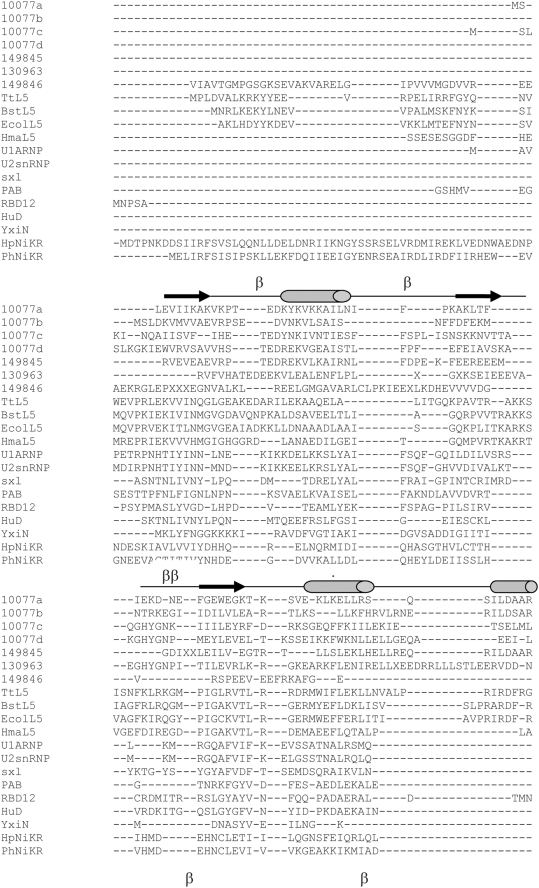
Sequence alignment of UPF0201 proteins (that include known structures and consensus sequences from 3 SYSTER families), L5 and non-L5 RRM containing proteins and NiKR.The secondary structural elements corresponding to 10077a (2PZZ) is shown at the top of the alignment with arrow marks and cylinders representing β strands and α helices. The turns are marked with the letter ‘β’.